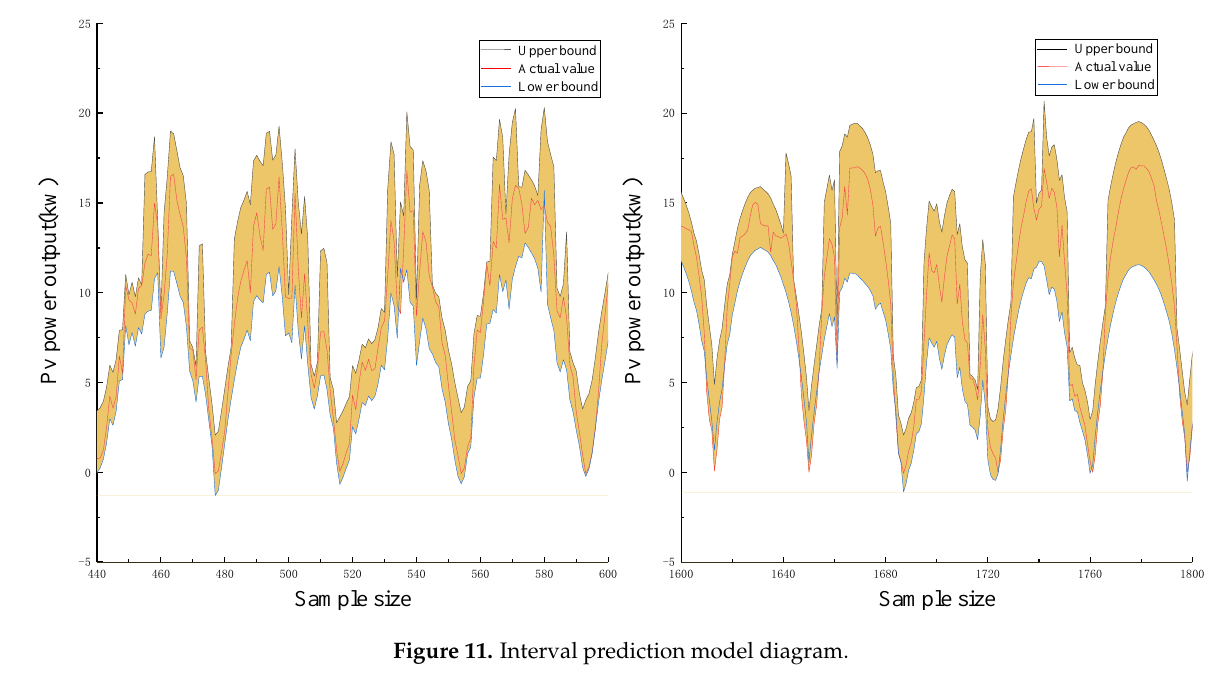
Figure 11. Interval prediction model diagram.